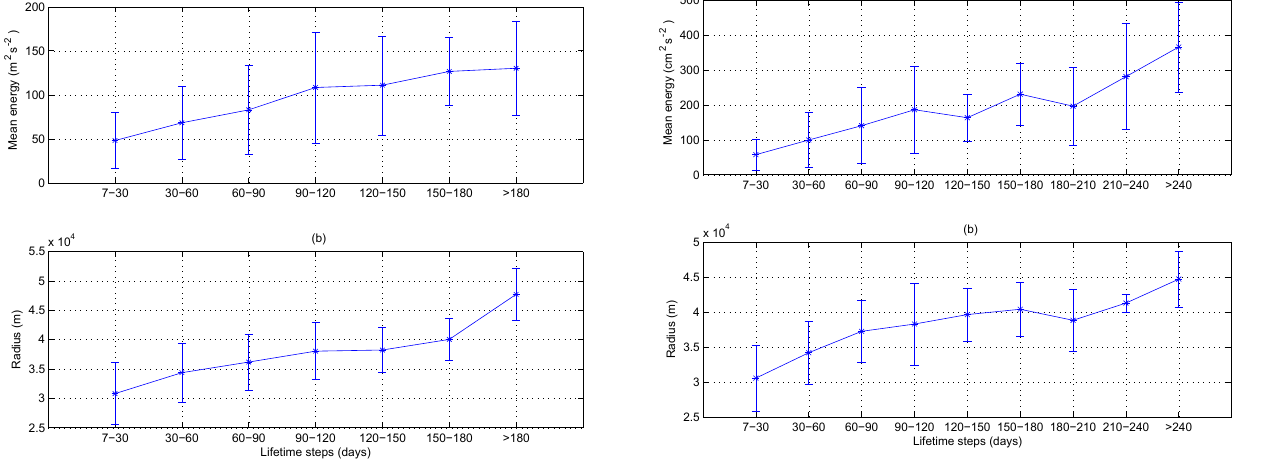
Figure 8. Relation between MEKE (a) , radius (b) and lifetime of cyclonic structures. Averages have been computed on the basis of MEKEs and mean radii of the cyclonic eddies in the basin.